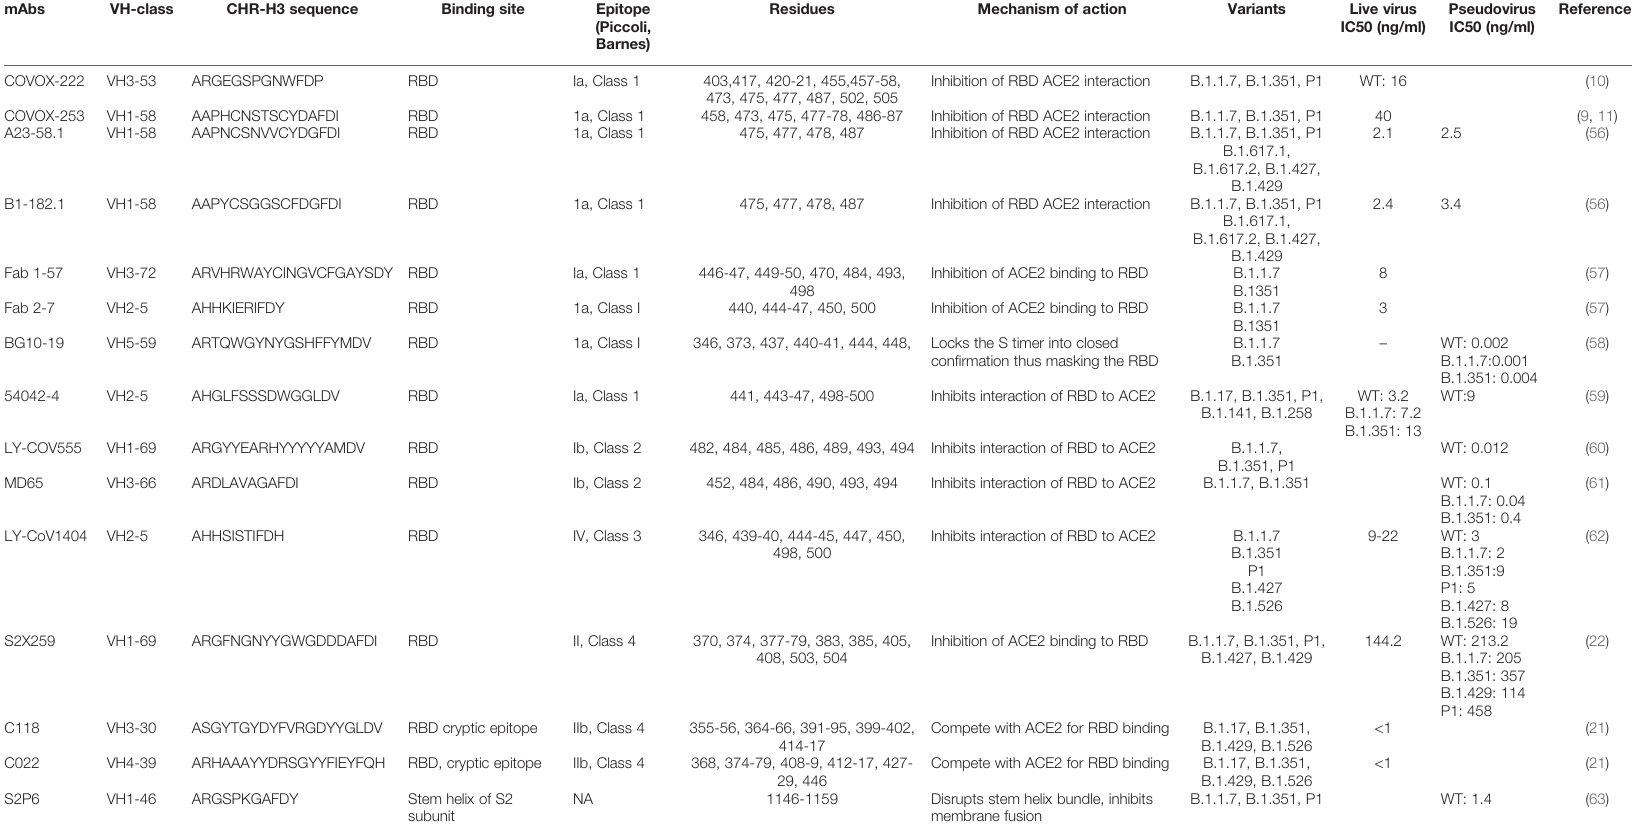
TABLE 2 | Monoclonal antibodies, their classi fi cation and mechanism of